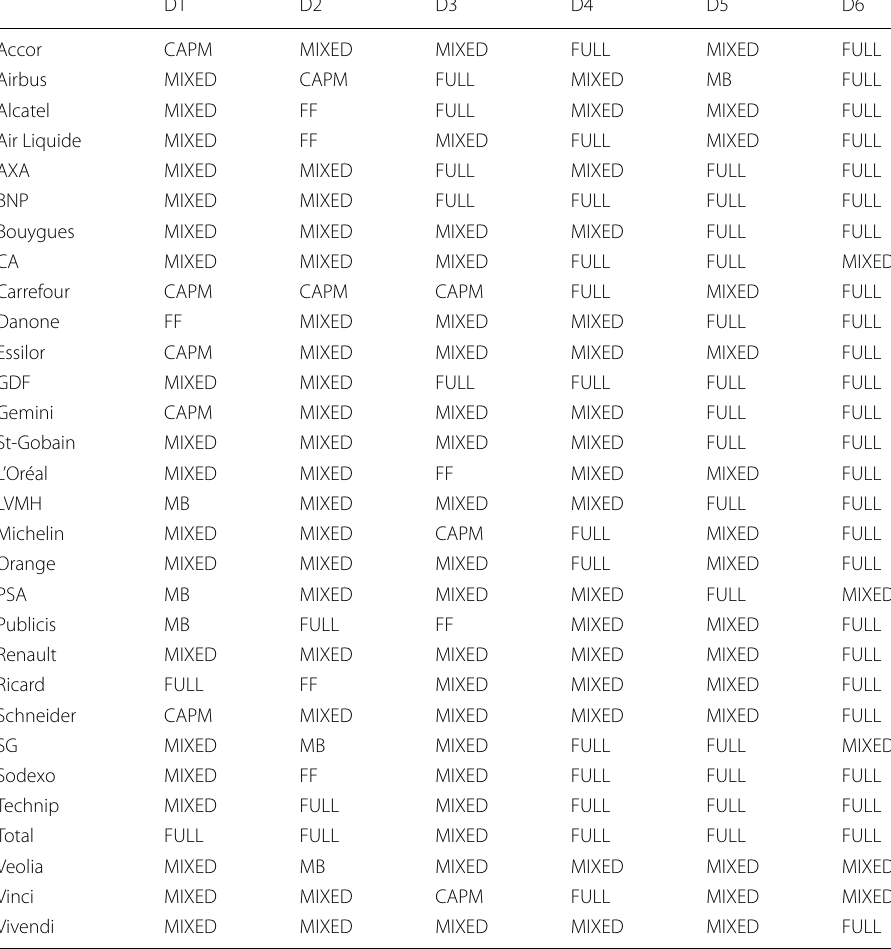
Table 13 Synthesis of time–frequency model for each stocks D1 D2 D3 Accor CAPM MIXED MIXED Airbus MIXED